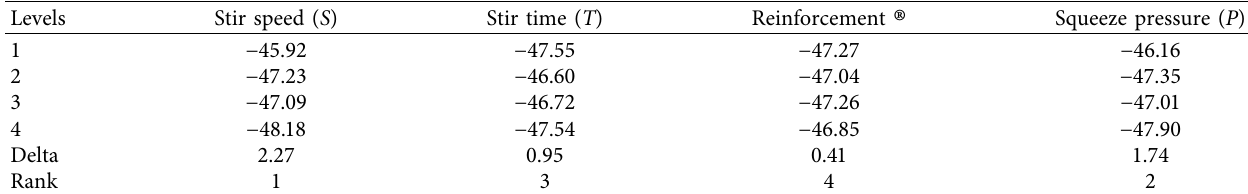
Table 5: Response table for SN ratios (smaller is better).